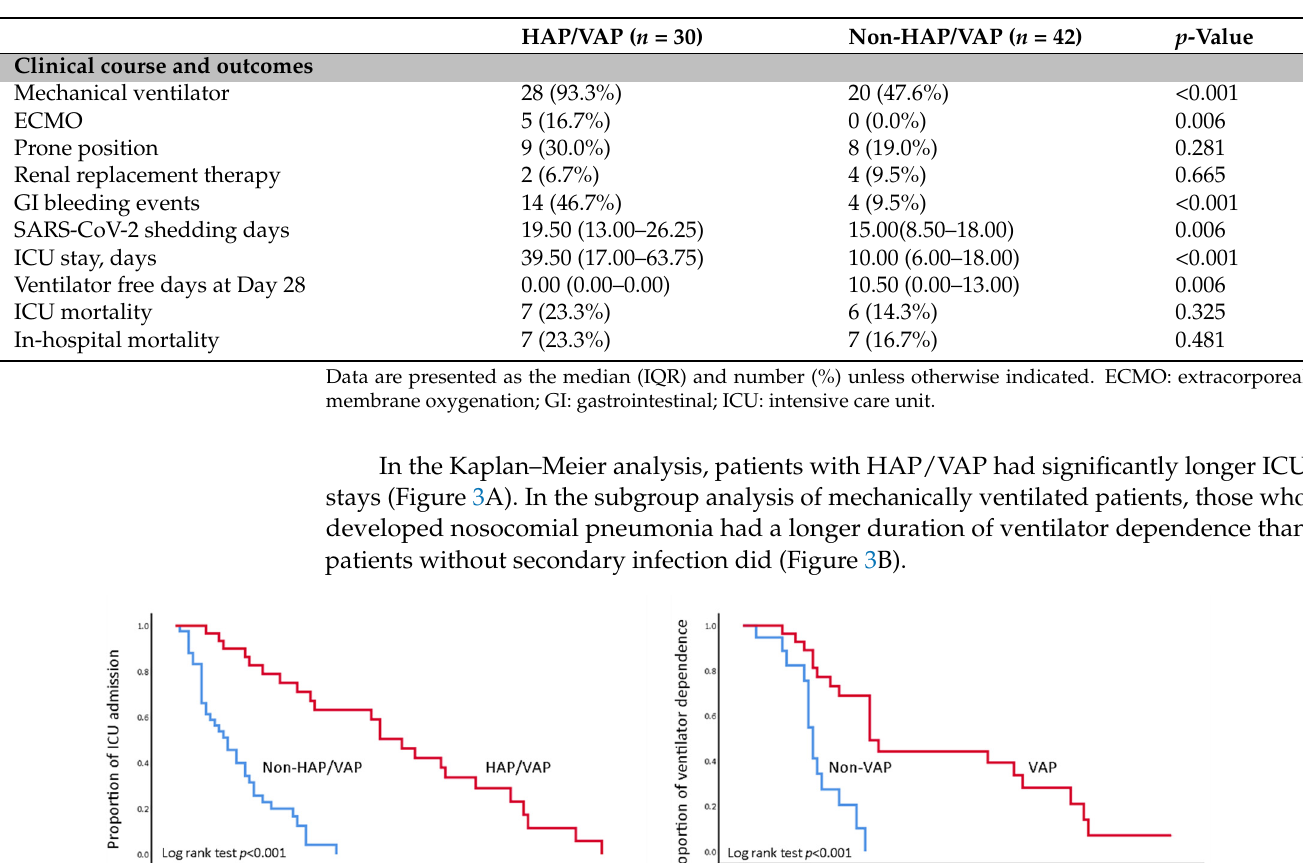
Table 2. Clinical outcomes of patients according to HAP/VAP status.